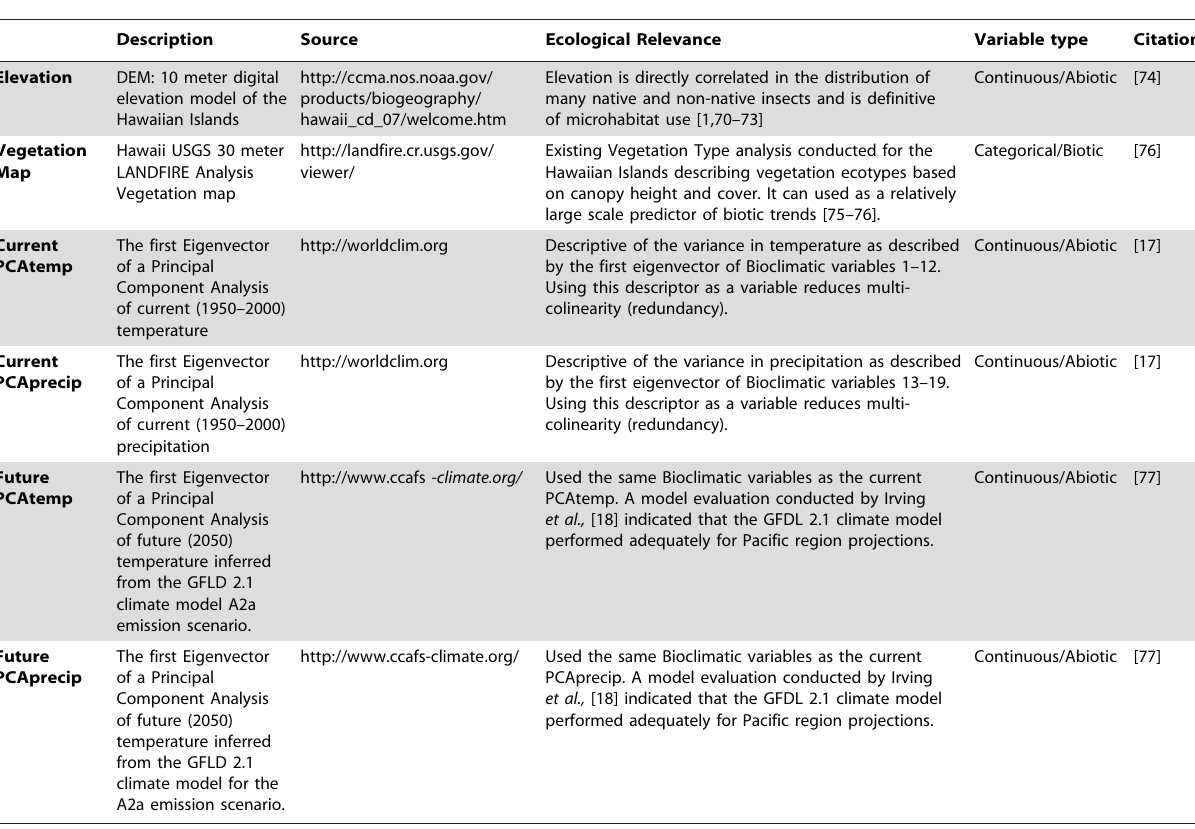
Table 1. An overview of the environmental variables used to define the ENM for O.